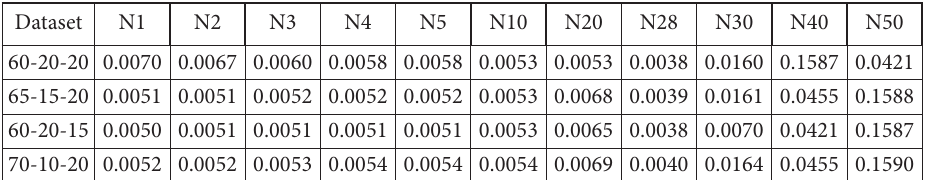
Table 2. FF5F based MSE Score of All Portfolios under Various Neurons (N) Dataset N1 N2 N3 N4 N5 N10 N20 N28 N30 N40